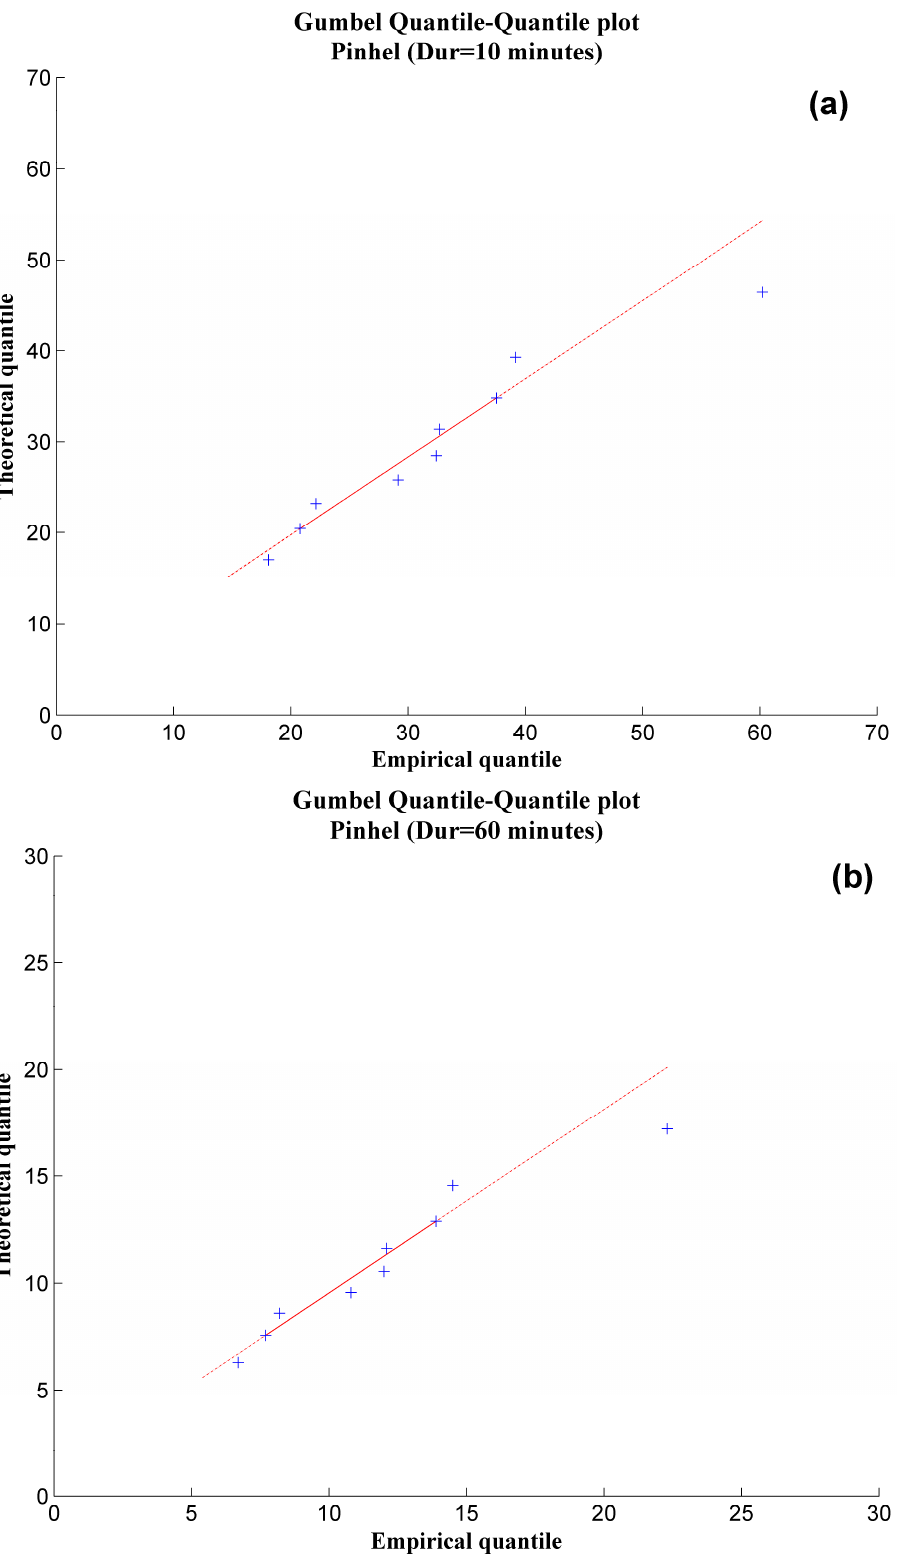
Figure 2. QQplots produced for the data observed in the weather station of Pinhel, for the durations of 10 min ( a ) and 60 min ( b ). 10 min ( a ) and 60 min ( b